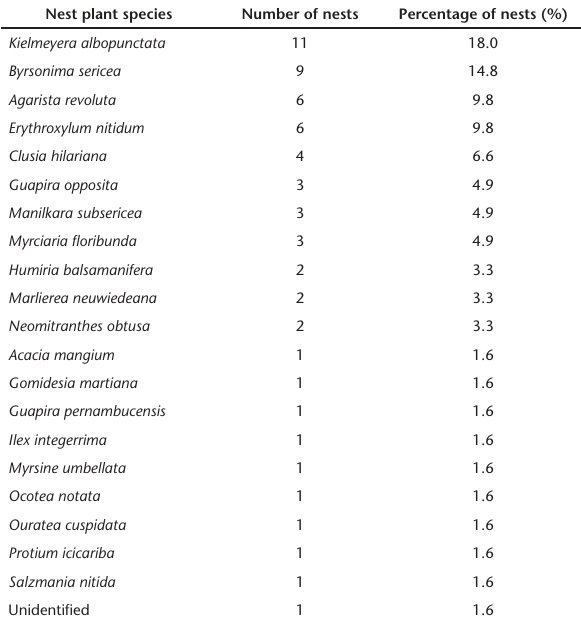
Table 1. Nest plant species used, number and percentage of Tyran- nus melancholicus nests per plant species at Setiba Environmental Protection Area, Guarapari,